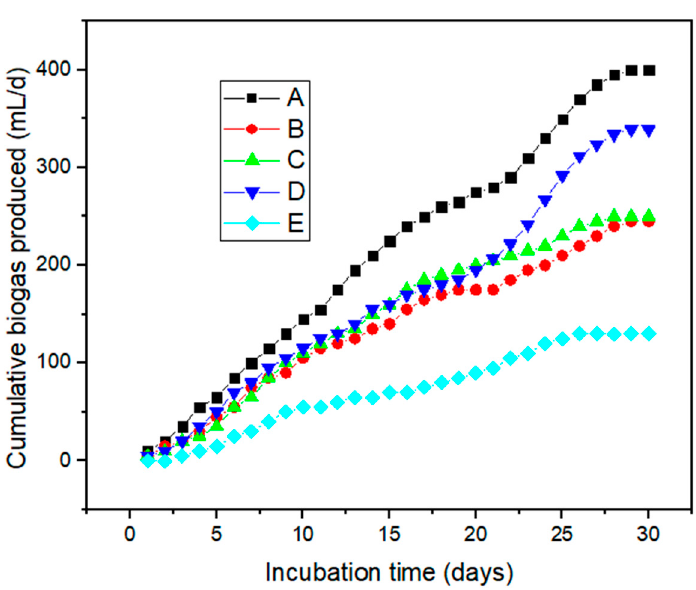
Figure 4. Cumulative biogas yield for 30 days of bioreactors A–D charged with 2 g of ( A ) Fe 2 O 4 -TiO 2 ; ( B ) Cu-Fe 2 O 4 ; ( C ) Fe 3 O 4 ; and ( D ) Chitosan-Fe 2 O 4 /TiO 2 MNPs, whereas bioreactor E is a control: ( E ) no MNPs .